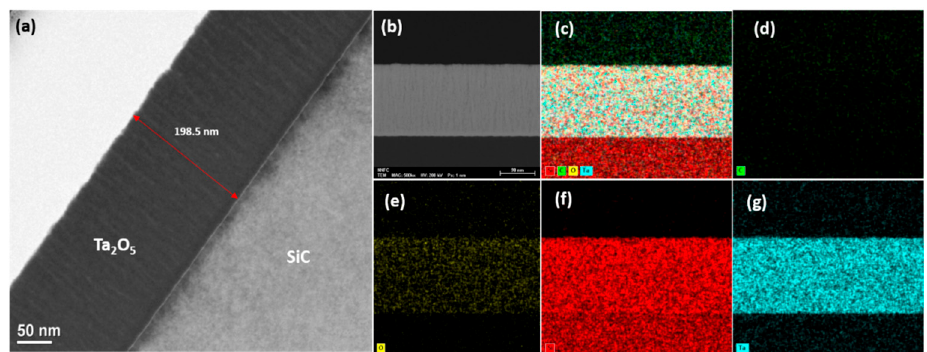
Figure 3. The HRTEM and EDS analysis of the fabricated device: ( a ) a cross-sectional HRTEM image indicating the film thickness; ( b ) the cross-sectional HRTEM image used for the EDS mapping analysis; ( c – g ) EDS elemental mappings of: ( c ) combined elements (d)carbon (C), ( e ) oxygen (O), ( f ) silicon (Si), and ( g ) tantalum (Ta).